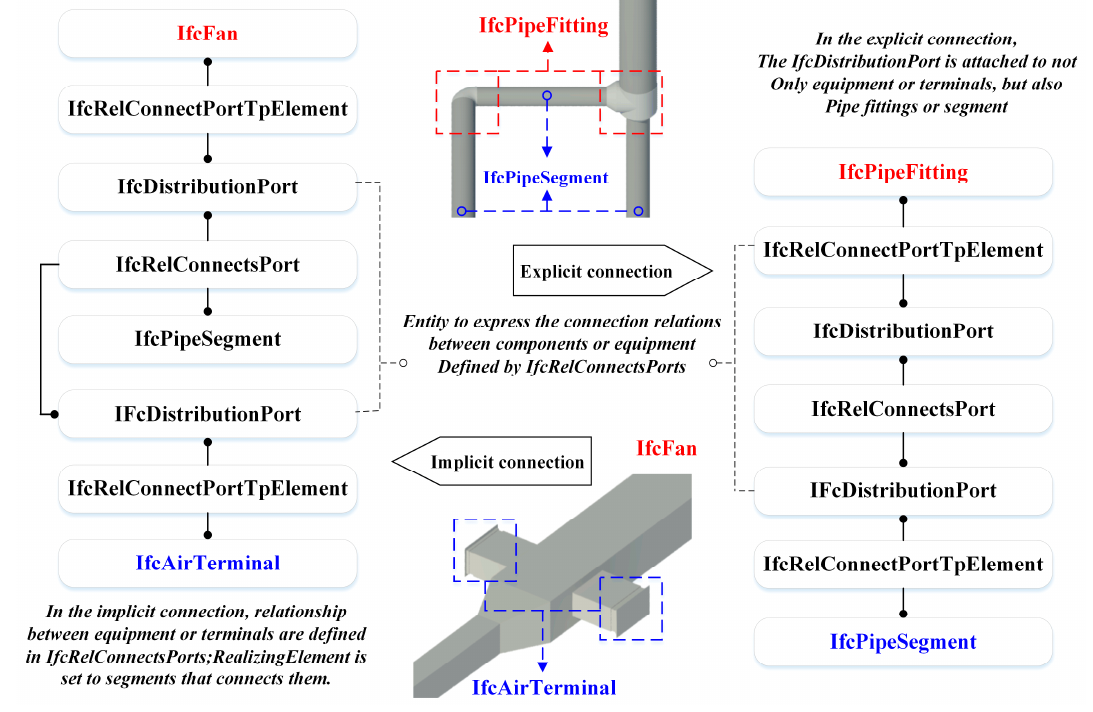
Figure 5. Expression of MEP connection information in IFC.